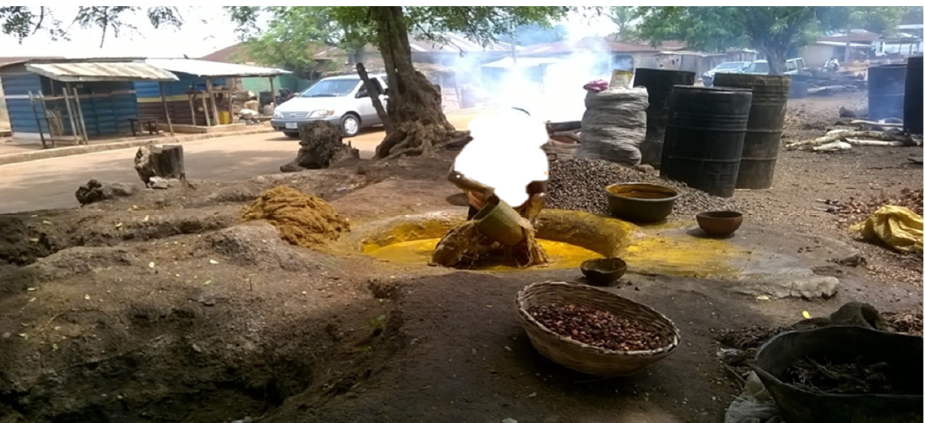
Figure 2. Ground-dug refining sludge pit from where POME was